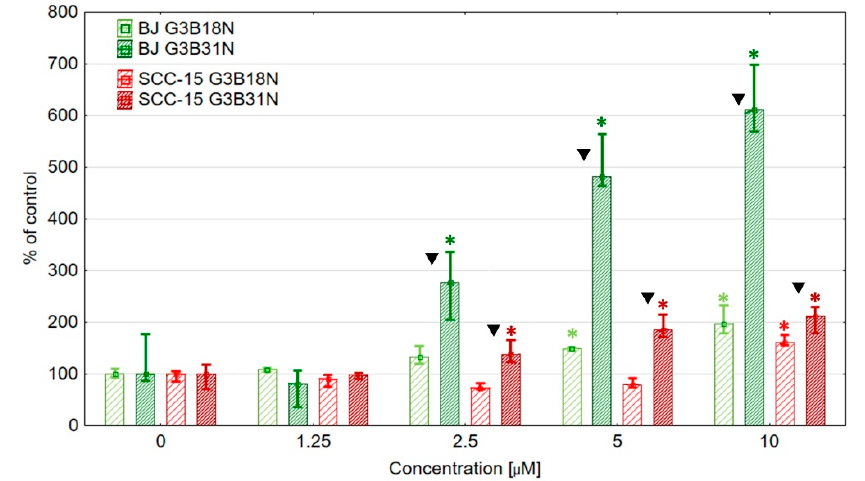
Figure 5. Activity of executive 3 / 7 caspases after 24 h treatment of BJ and SCC-15 cells with G3 B18N and G3 B31N conjugates, expressed as a percentage of control. Squares show medians, and whiskers are lower and upper quartile. * p < 0.05 significant difference against control (Kruskal-Wallis test). Triangles show significant differences between conjugates for the same cell lines (Mann Whitney U test, p <0.05).